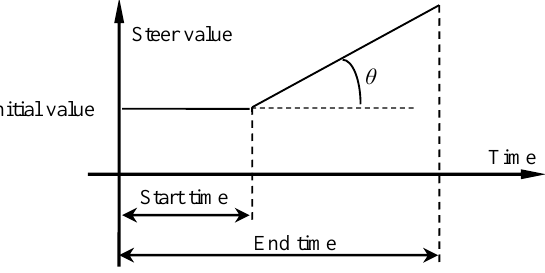
Figure 11. The curve of the input versus the time for the ramp steer test.